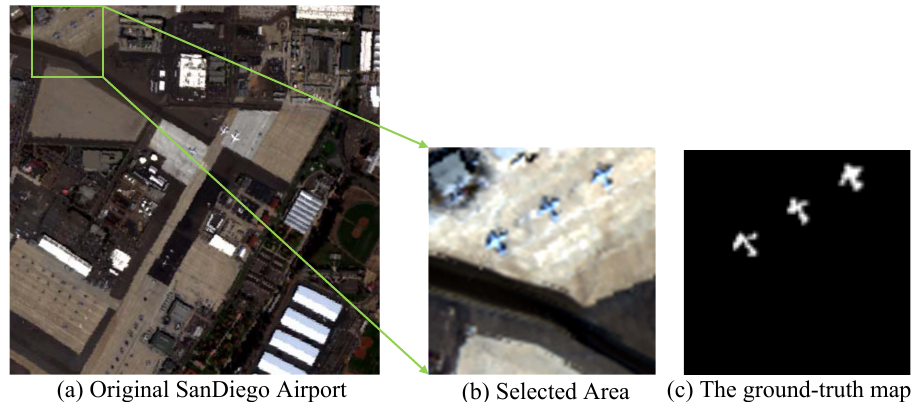
Figure 6. Sandiego80